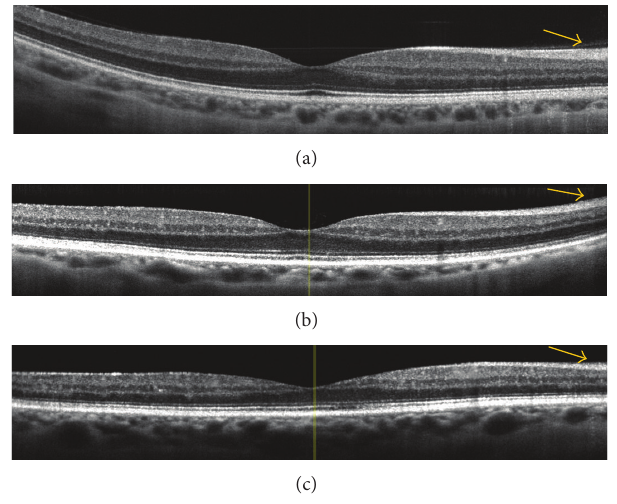
Figure 4: Spectral domain OCT linear scans in the macula of (a) normal subject, (b) diabetic patient without retinopathy, and (c) diabetic patient with mild nonproliferative diabetic retinopathy. The arrows indicate a progressive thinning of the retinal nerve fiber layer in diabetics (without and with retinopathy) versus normal